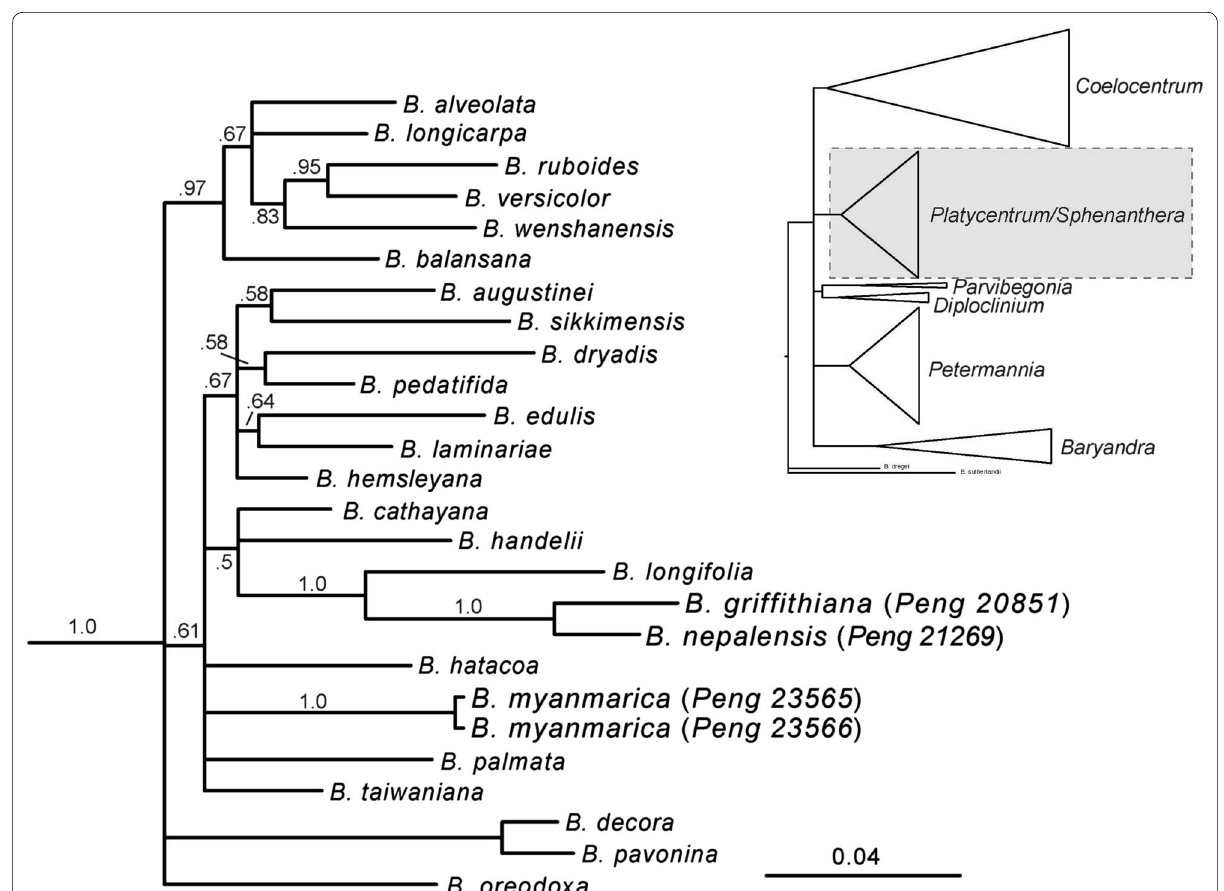
Fig. 6 Phylogenetic tree of section Platycentrum ‑section Sphenanthera in Begonia generated from Bayesian analysis of nrITS sequence data. Num- bers on the branches indicate posterior probability of Bayesian inference analysis. The inset is simplified phylogenetic tree based on the nrITS dataset and sectional classification of Chung et al.